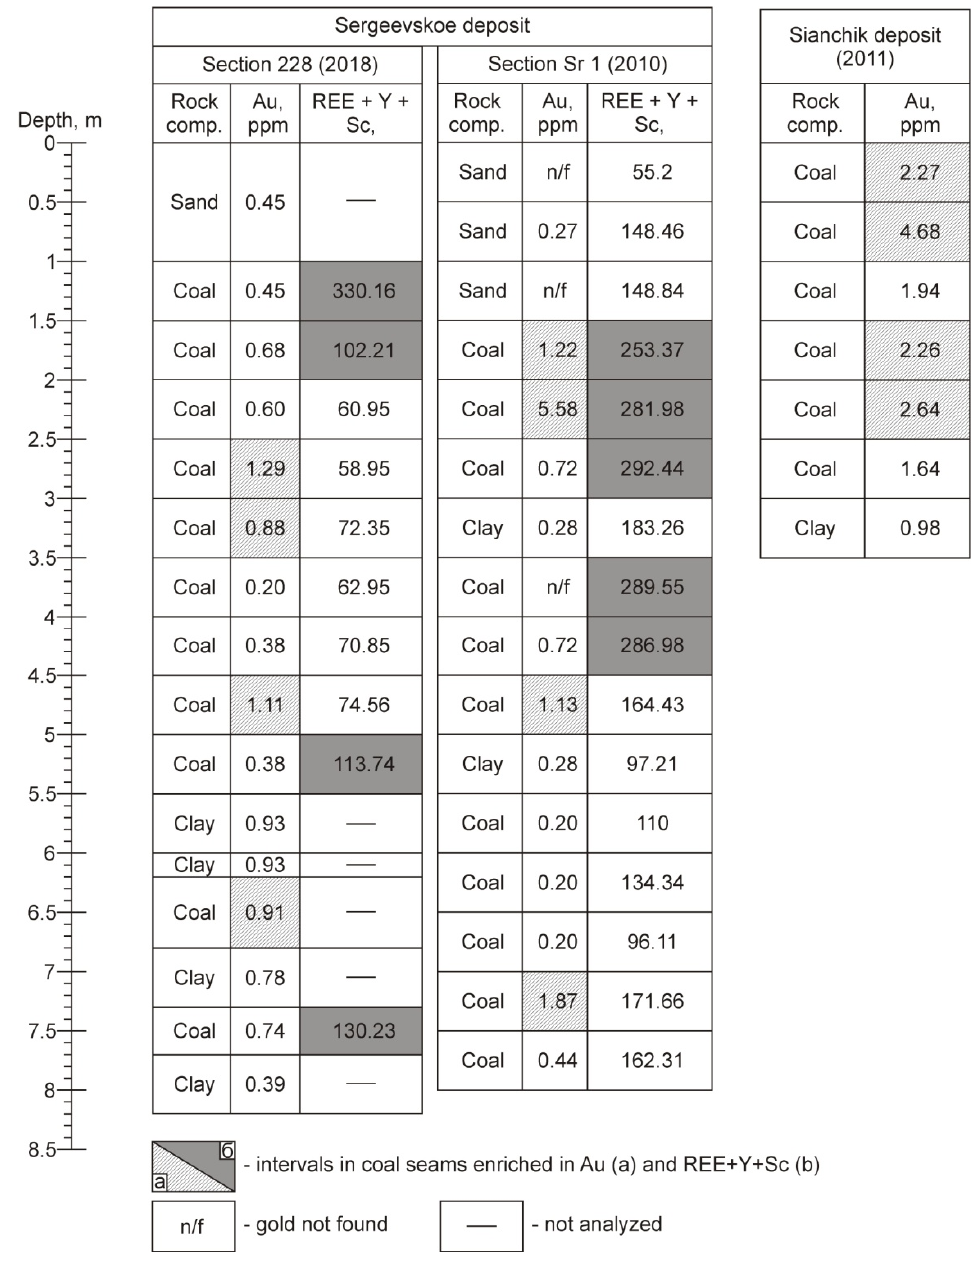
Figure 6. Distribution of Au & REE + Y + Sc in the Lower–Middle Miocene coals of the Sergeevskoe and Sianchik deposits.